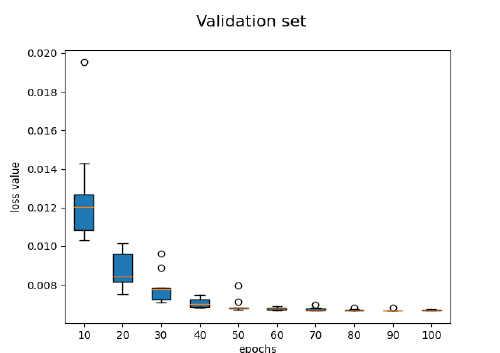
Figure 10. Validation loss of moiré